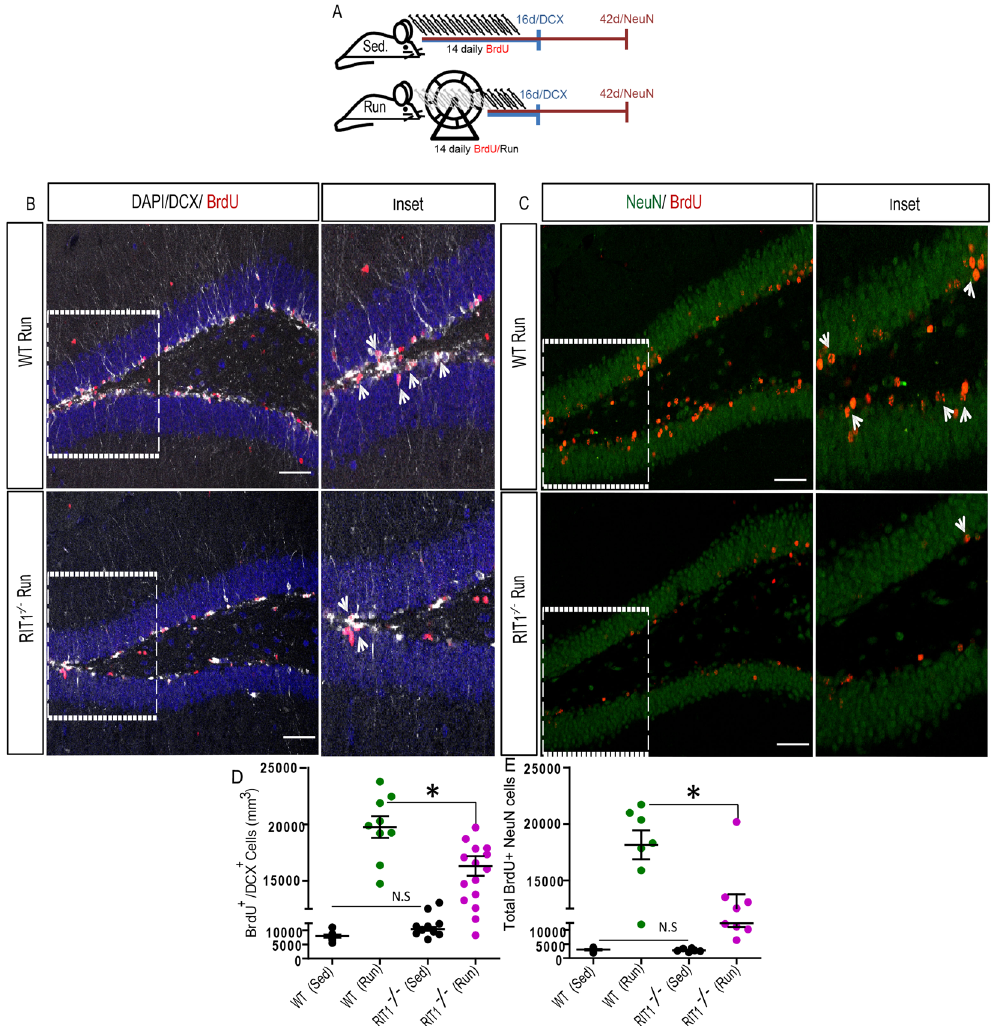
Figure 1. Adult neurogenesis in RIT1 − / − and WT littermates housed under running conditions. ( A ) Schematic of experimental design (see methods for details). WT and RIT1 − / − mice were injected daily with BrdU (50 mg/kg, i.p) for 14 days while housed in either sedentary or running cages and either analyzed for newborn neuroblasts (DCX + /BrdU + ) (day 16) or the generation of mature neurons (NeuN + /BrdU + ) (day 42). Representative coronal hippocampal sections from the dentate gyrus of ( B ) 16d mice immunostained for DCX ( white , pseudocolor), BrdU ( red , white arrowheads ) and DAPI, or ( C ) 42d mice co-immunostained with NeuN (green) and BrdU ( red ; white arrowheads ). The inserts are at higher magnification. The arrow heads indicate either newborn neuroblasts ( B ) or mature neurons ( C ). Scale bar, 20 μ m. ( D ) Quantitative analysis of newborn immature hippocampal neurons (BrdU + /DCX + ) following 16 days of running or sedentary housing ( * p < 0.01, two-way ANOVA). ( E ) Quantitative analysis of BrdU + mature neurons (NeuN + ) at day 42 ( * p < 0.01, two-way ANOVA). The results are presented as mean ± SEM (WT, n = 17; RIT1 − / − , n =